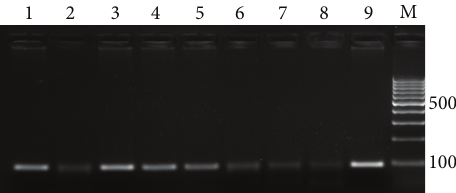
Figure 2: Agarose gel electrophoresis of ttr gene amplicon. lanes 1, 3, 4, and 5 are positive PCR product, lane 8 is negative control, lane 9 positive control, and lane 10 is DNA